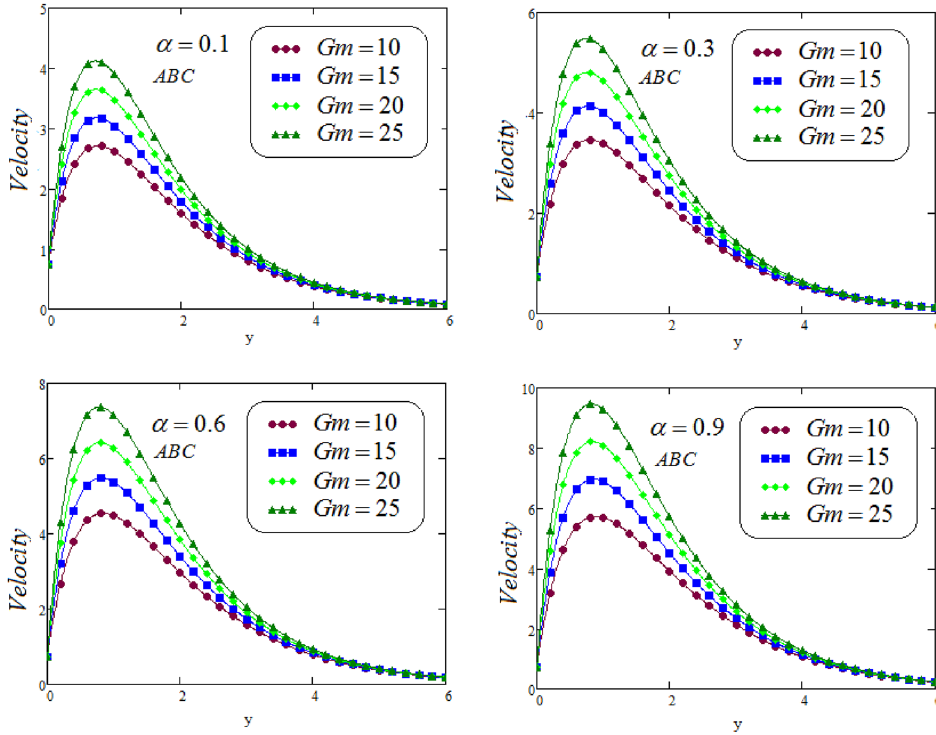
Figure 7. Representation of second grade fluid velocity via ABC for distinct values of Gm .